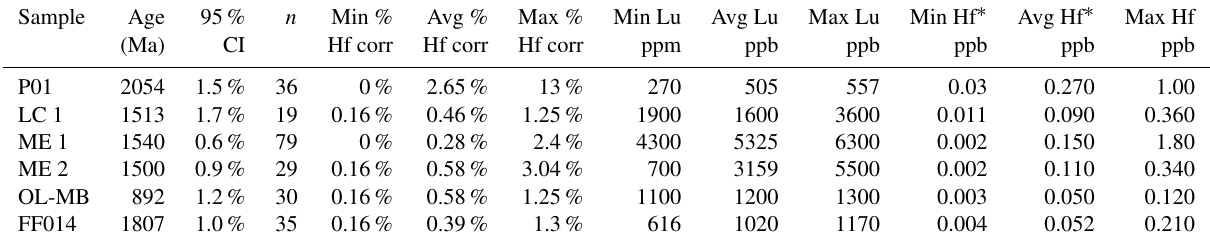
Table 1. Ages and Lu and Hf concentration information for the analysed samples.